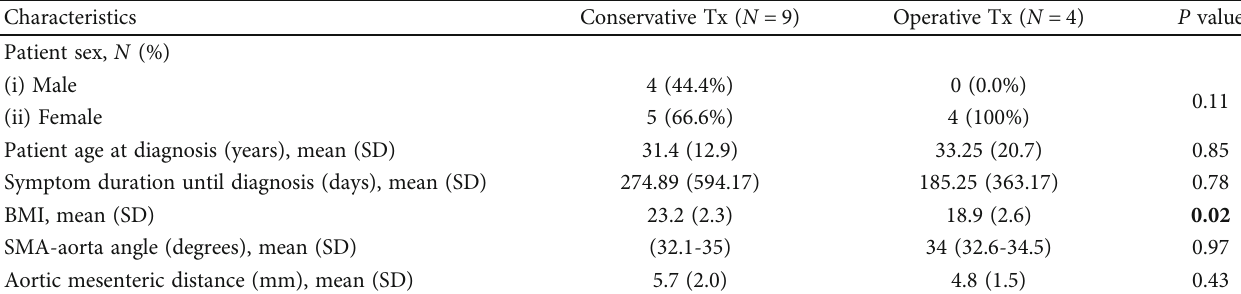
Table 2: Characteristics of conservatively treated vs. operatively treated